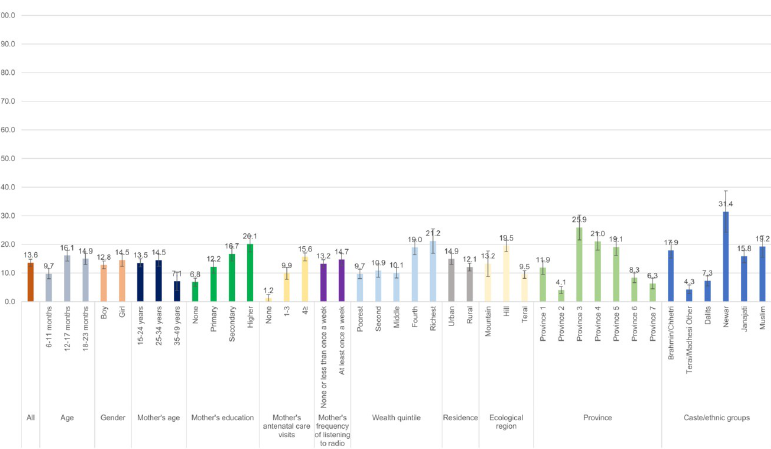
Fig 5. Percentage of Nepalese children aged 6 to 23 months consuming eggs by sociodemographic factors.